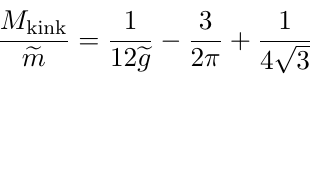
g and comparison with refs. [10] and e